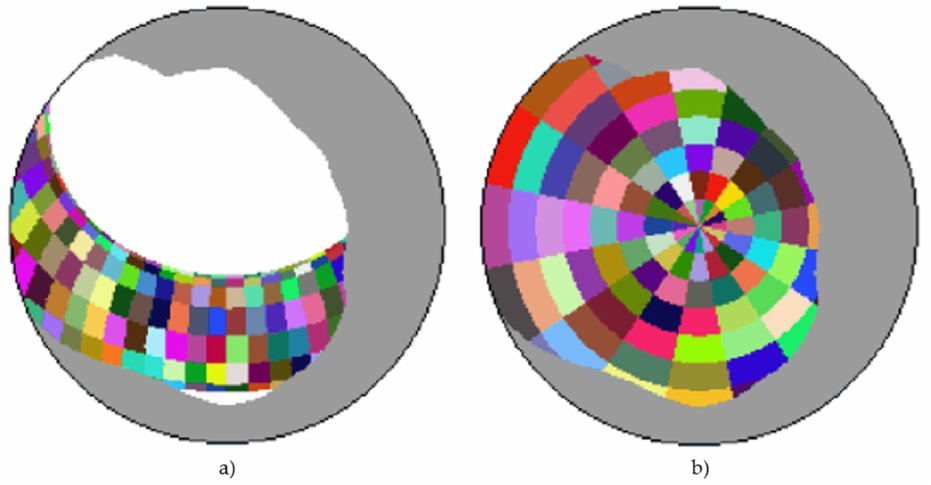
Figure 15. The viewshed superimposed ( a ) on the sun map; ( b ) on the sky map (grey colour marks obstructed sky directions